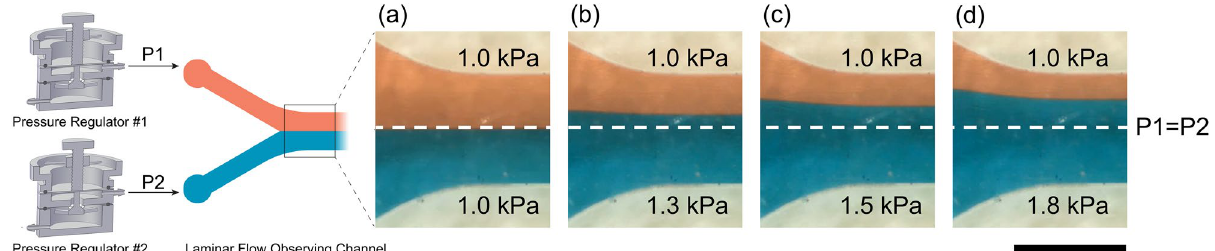
Figure 8. Real-time observation of co-laminar liquid flow pressurized with two µPRs. µPR #1 supplies pressure (P1) to one inlet port of the laminar flow observing channel, while µPR #2 supplied pressure (P2) to the